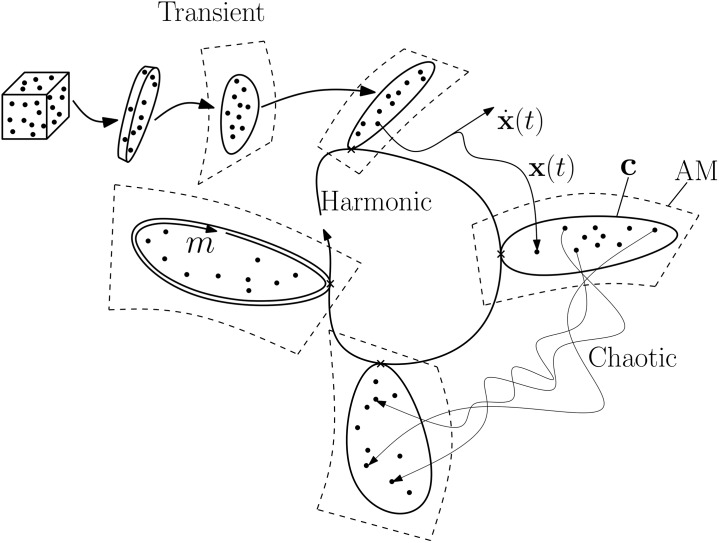
Schematic showing the contraction of a set of initial conditions along off-manifold directions onto the AM and the post-transient harmonic behaviour of the AM and BM.The parameter m runs from 0 to 1 along the length of the BM. A number of solutions are shown as dots. Initially they lie as a cloud in phase space, but they rapidly contract along stable directions until they converge to the AM. As shall become apparent, it is sufficient to calculate the tangent space of the AM to orientate the BM c(m, t). This is done with a spectral method.